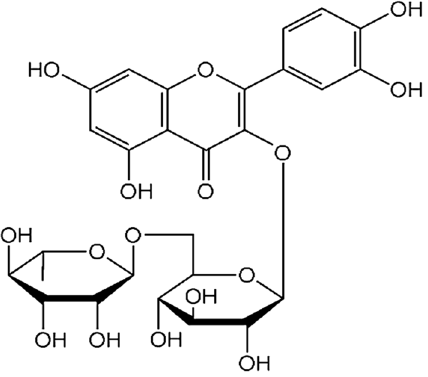
Fig. 3 Structure of rutin (3,3 ′ ,4 ′ ,5,7-pentahydroxyflavone-3-rhamno- glucoside)